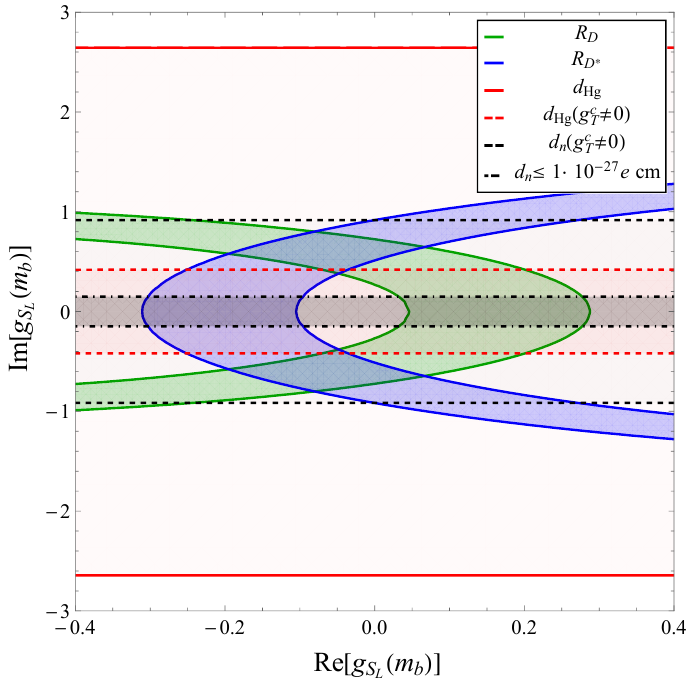
( m b )-Im g S ( m b ) plane. The R D and R (cid:3) contours (at 90% D L L